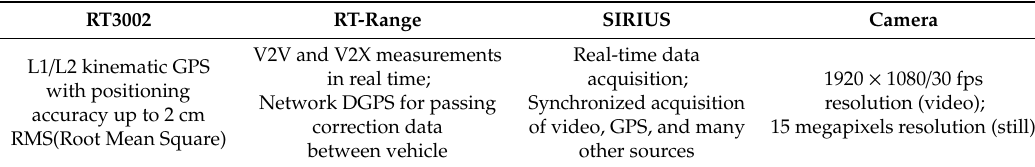
Figure 5. Test equipment mounted on vehicle. Table 2. Specifications of test equipment.